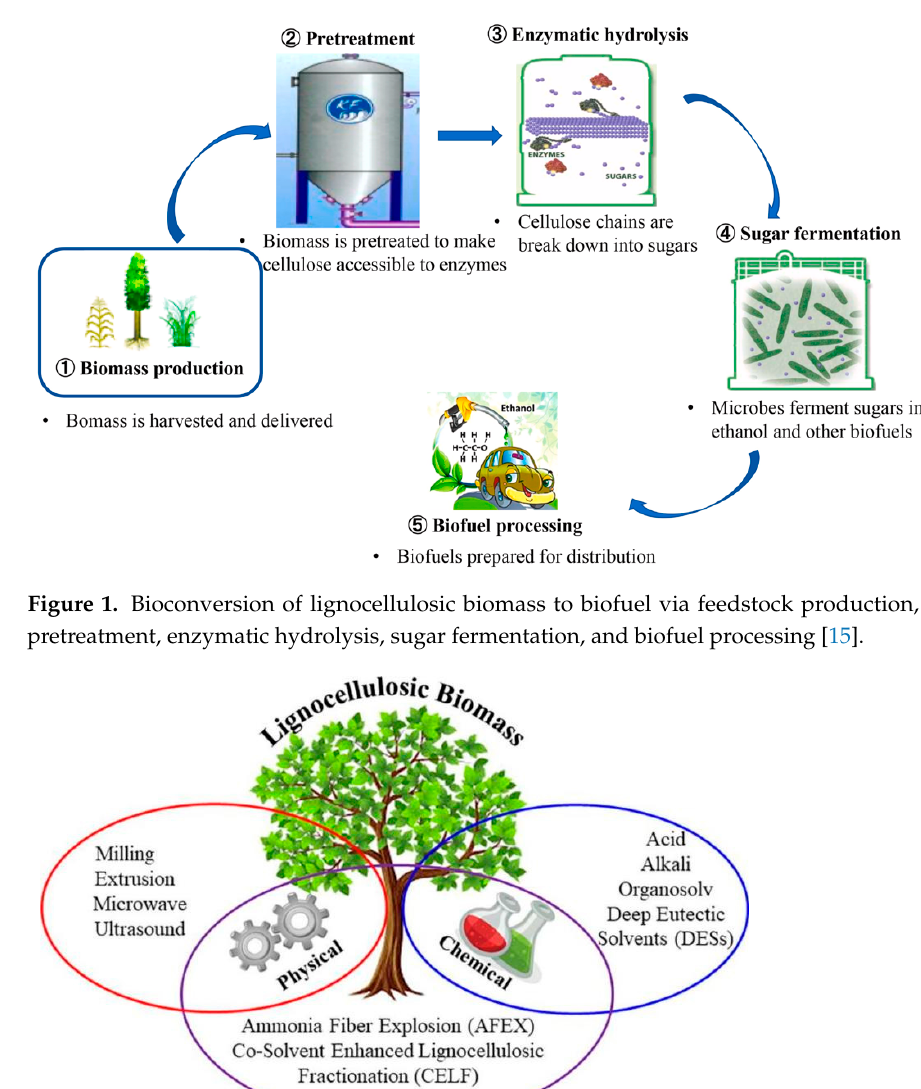
Figure 3. The action of various cellulases enzymes on surface layer of cellulose [21].